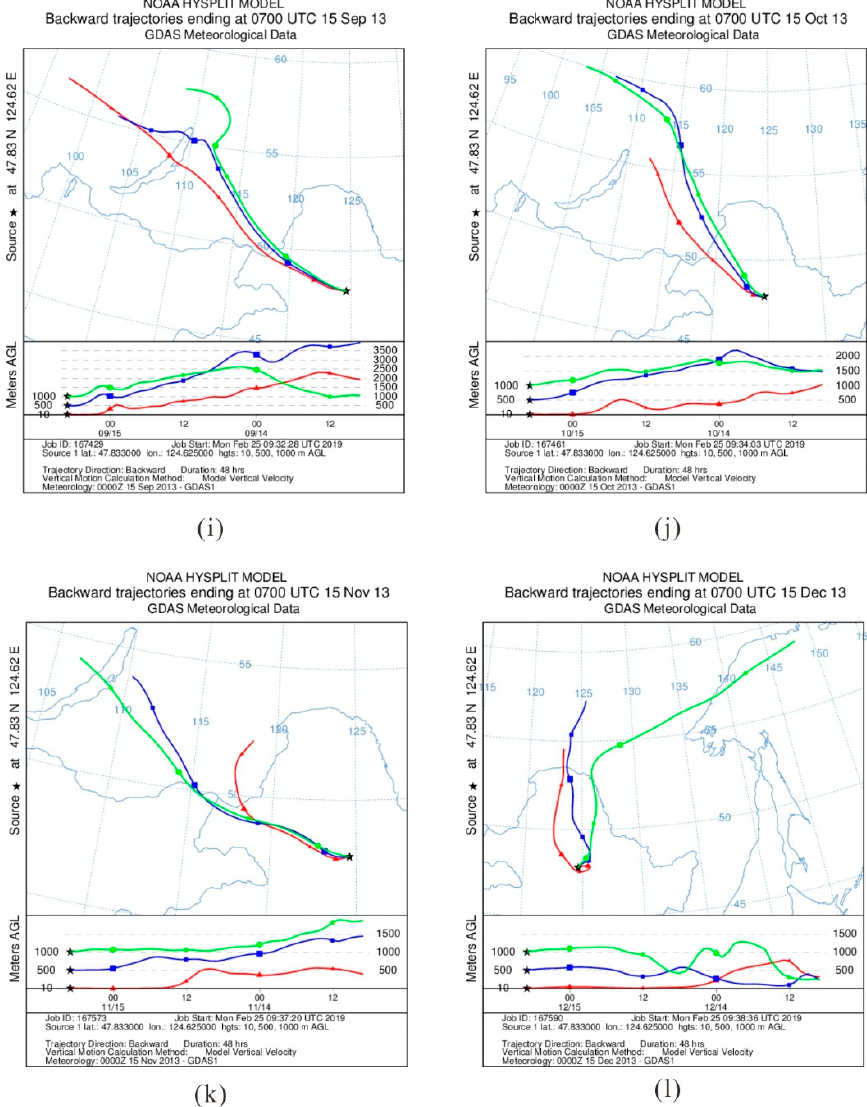
Figure 4. The 48-h air mass back-trajectories for starting altitudes of 10, 500, and 1000 m above ground level (AGL) calculated from the Global Data Assimilation System (GDAS) Database of the National Ocean and Atmospheric Administration (NOAA) and simulated by using the Hybrid Single-Particle Langrangian Integrated Trajectory (HY-SPLIT) model: ( a ) January 2013; ( b ) February 2013; ( c ) March 2013; ( d ) April 2013; ( e ) May 2013; ( f ) June 2013; ( g ) July 2013; ( h ) August 2013; ( i ) September 2013; ( j ) October 2013; ( k ) November 2013; ( l ) December 2013.